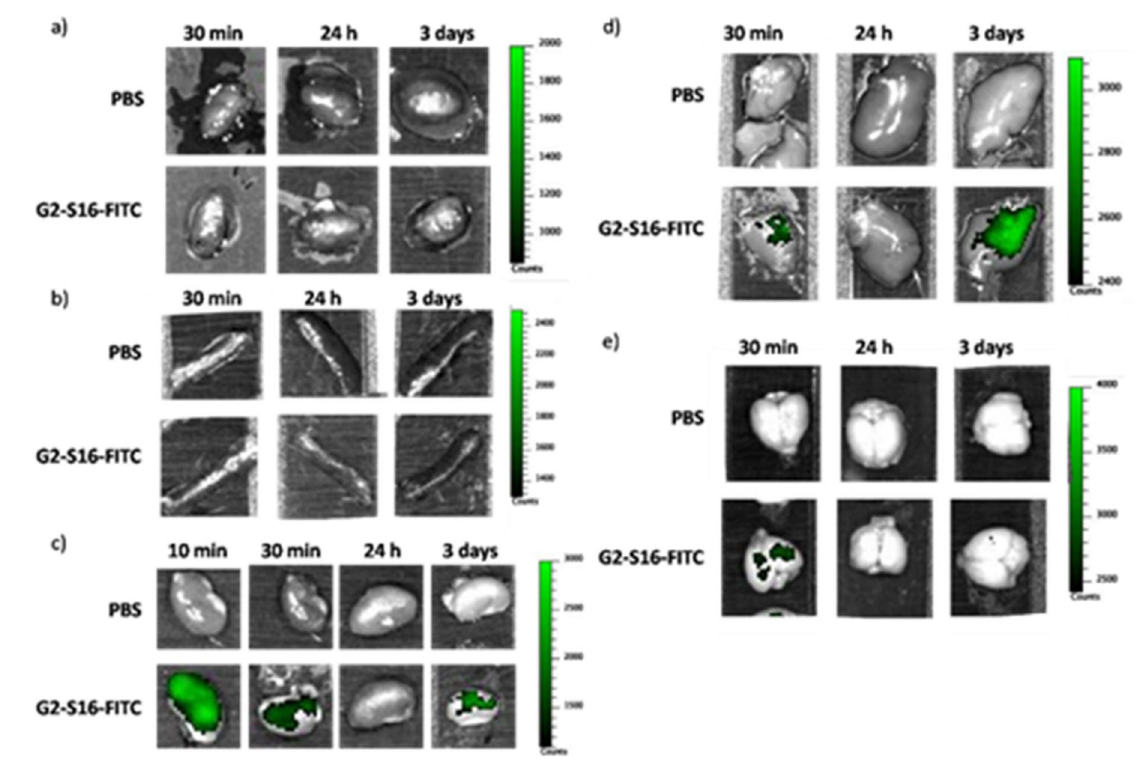
Figure 6. In vivo imaging of G2-S16-FITC dendrimer in different organs after IV-treatment of CD1 mice. CD1 mice were treated intravenously with PBS or G2-S16-FITC dendrimer and organs were harvested 30 min or 24 h after treatment, or 24 h after 3 daily applications. In vivo imaging was used to assess whether the G2-S16 dendrimer reaches and accumulates in the ( a ) heart, ( b ) spleen, ( c ) kidney, ( d ) liver and ( e ) brain. Intensity of fluorescence is represented in a scale of green. As expected, given the lack (or minimal) dendrimer accumulation, a histological evaluation of the heart, brain, and spleen (Figure 7) showed no tissue damage in the organs from mice treated with 1 or 2.5 mg/kg of G2-S16 dendrimer. Similarly, the kidney (Figure 7) suffered no histological modifications besides the observed G2-S16 dendrimer accumulation over time. Although the liver was the most affected organ (Figure 7), as we found some minimal histological damage, the affects were minimal and there were no differences between the PBS controls and the G2-S16 dendrimer-treated